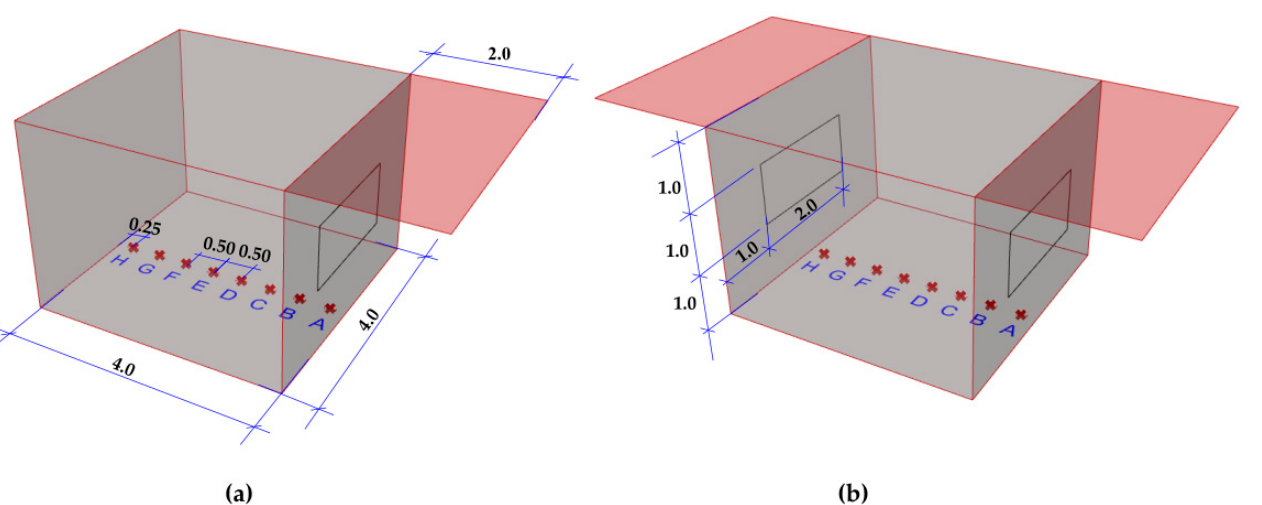
Table 1. Radiance parameter settings.